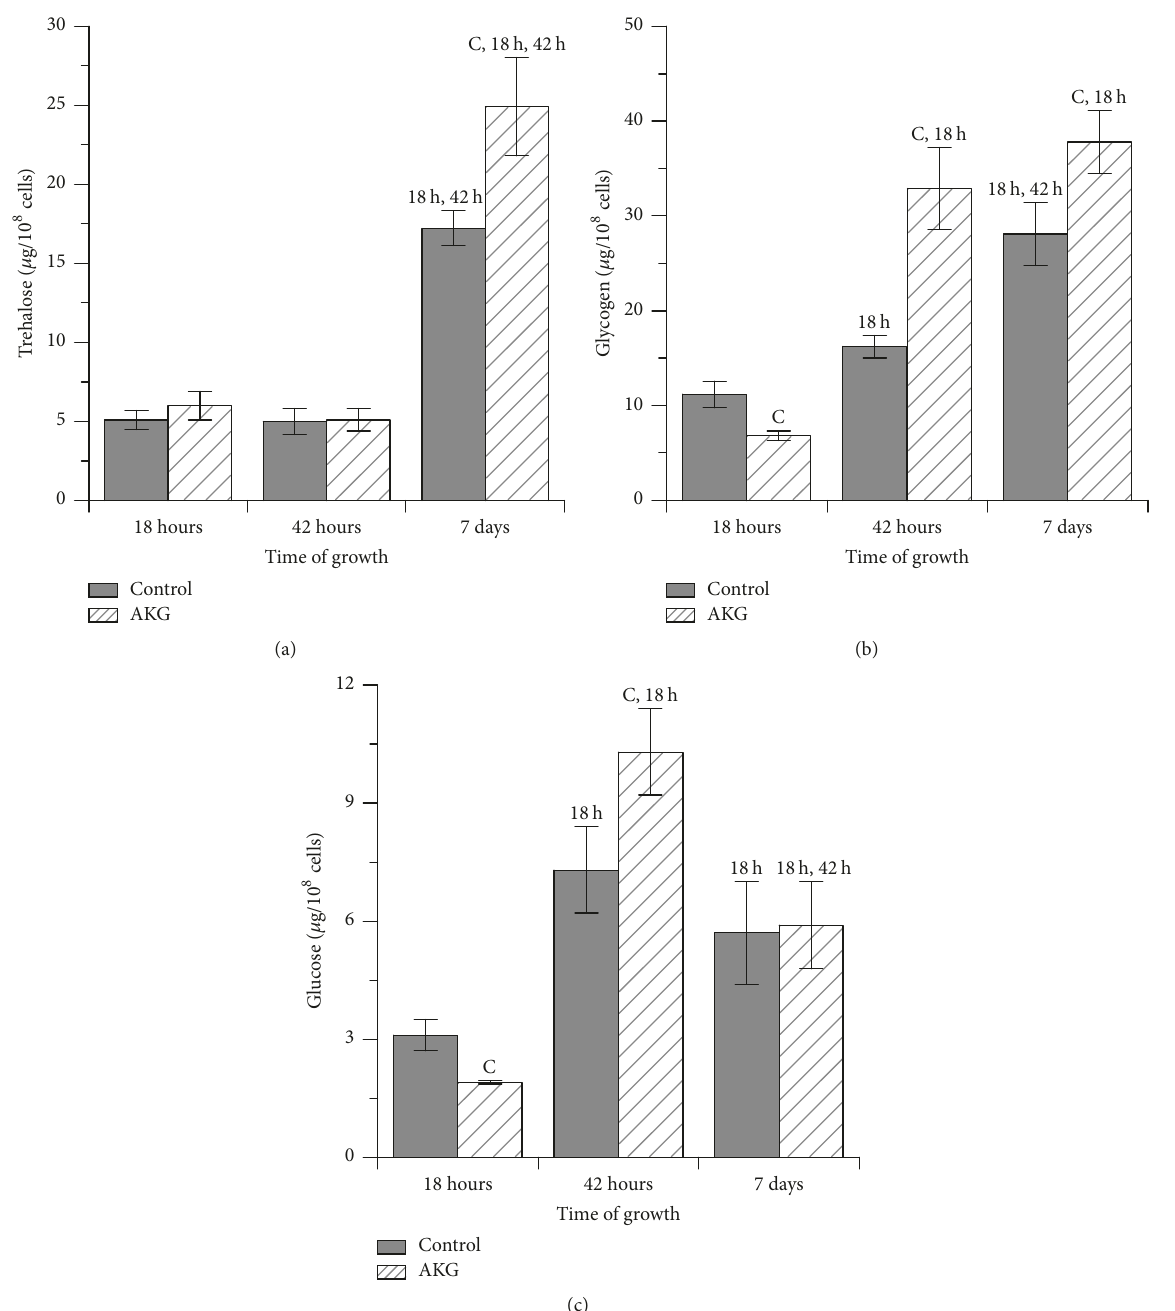
Figure 3: Levels of reserve carbohydrates, trehalose (a) and glycogen (b), and free glucose (c) in S. cerevisiae cells grown during 7 days in the control medium or in the medium supplemented with 10mM AKG. Results are shown as means ± SEM ( 𝑛 = 6 –8). Statistic as in Figure